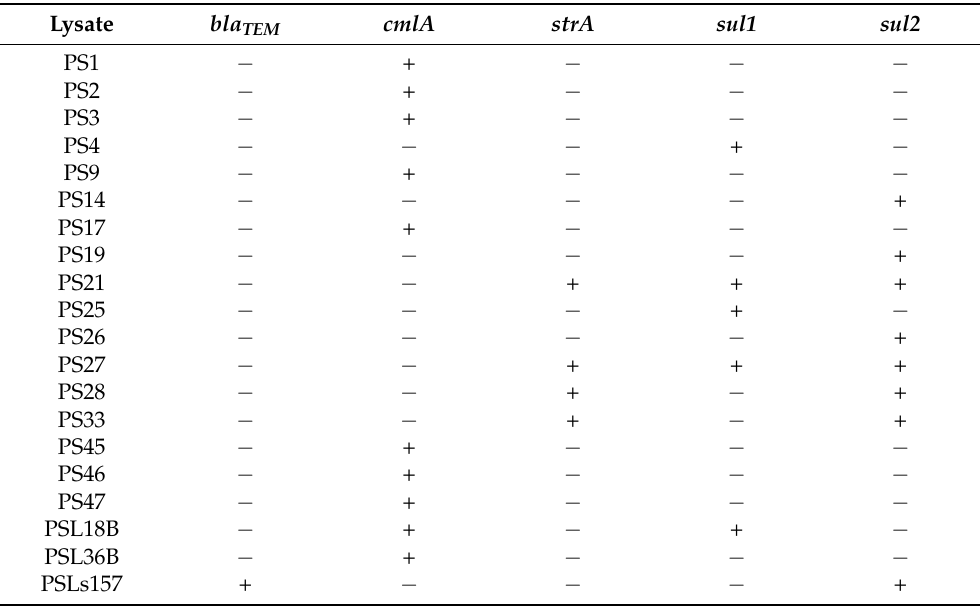
Table 1. PCR detection of resistance genes in phage DNA isolated from propagated lysates of S . serovar